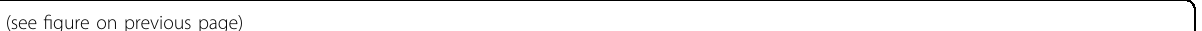
Fig. 5 Clonal expansion of CD8 + T cells and clonal maintenance of CD8 + Effector-GNLY cells following ART. a t -SNE of CD8 + T cells. Clusters are denoted by color labeled with inferred cell types (left) and TCR detection (right). Cells are colored the same as in Fig. 1d. b Bar plots showing the percent of TCR detection in each CD8 + T cell cluster. c The association between the number of CD8 + T cell clones and the number of cells per clonotype. The dashed line separates non-clonal and clonal cells, with the latter identi fi ed by repeated usage of TCRs. LOESS fi tting is labeled as the solid line showing a negative correlation between the two axes. d The distribution of the clone state of CD8 + T cells in each cluster across the three conditions. e Comparison between the fraction of clonal cells in each subset ( X -axis) and percentage of cells with TCRs shared across clusters ( Y -axis). f Developmental transition of CD8 + Effector-GZMH cells with other CD8 + cells quanti fi ed by pairwise STARTRAC-tran indices for each patient ( n = 14). *** P < 0.001, Permutation test. g Top 5 paired V-J usage of TRA/B genes across four healthy donors and 14 chronic HIV-1-infected individuals. h Scatterplots comparing TCR clone frequencies between pre- and post-ART treatment for three participants. The size of the dot corresponds to the number of distinct clonotypes. The clonotypes that are shared between pre- and post-ART are displayed in blue, and those only in TP or ART are in green or orange,